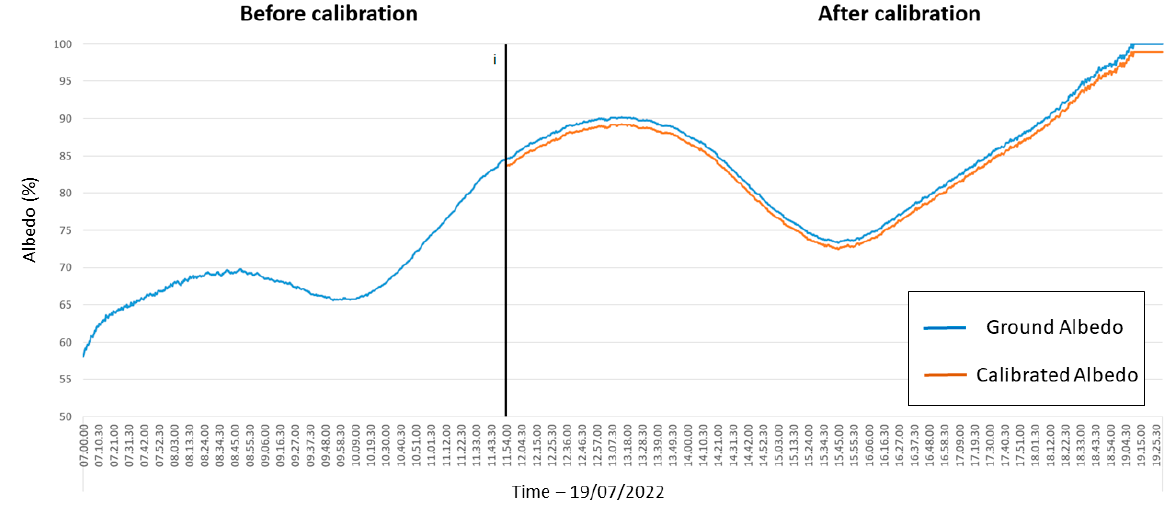
Figure 6. Ground albedo measurement (blue line) and calibrated albedo (orange line).